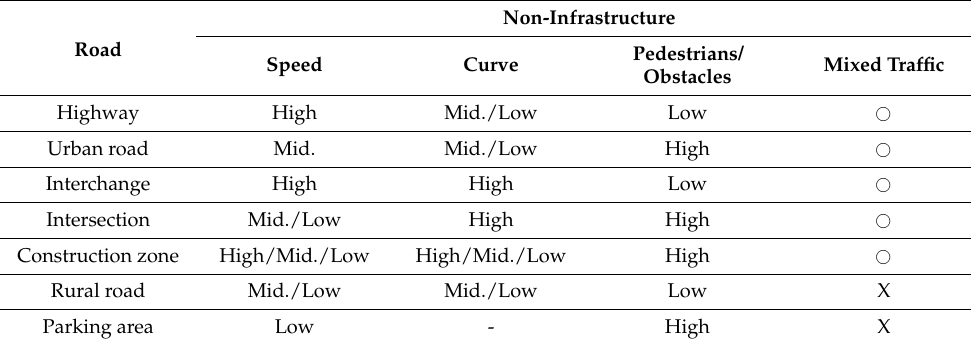
Table 6. Scenario classification—road (non-infrastructure).